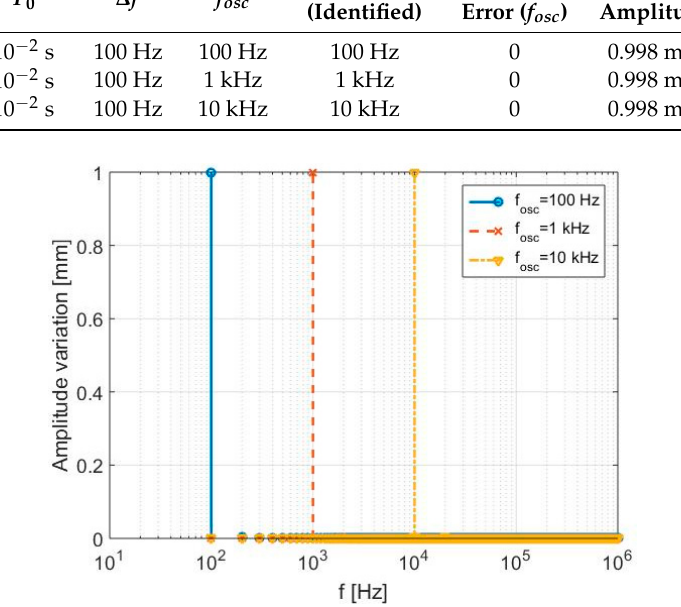
Table 2. First simulation—Parameters and results.